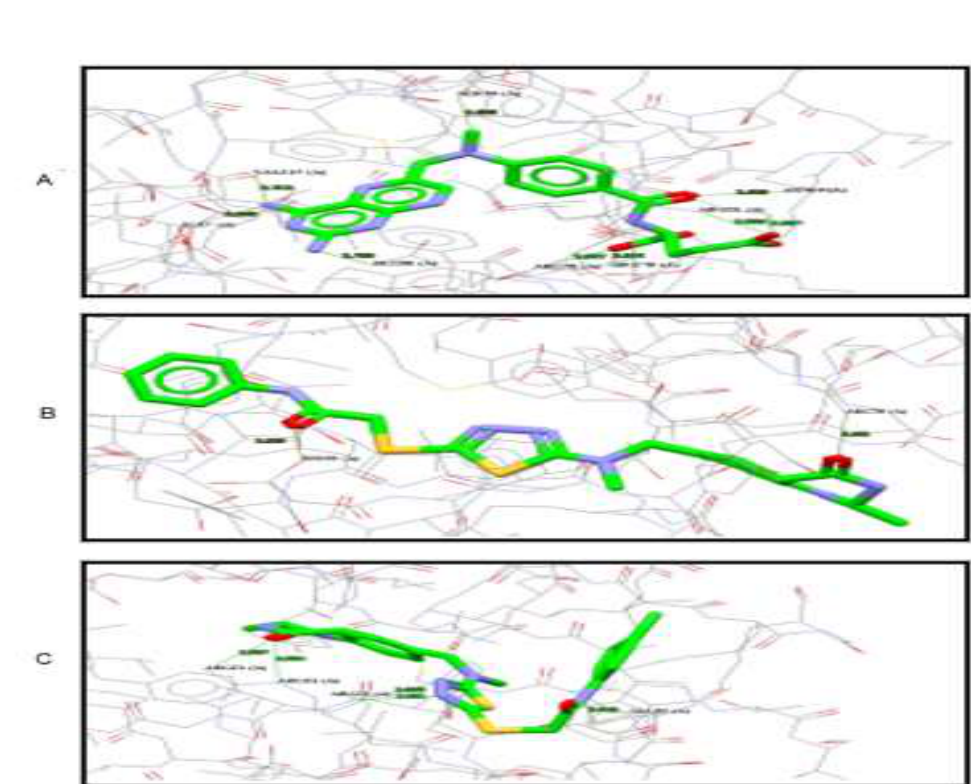
Figure 6 . Comparison of binding mode of methotrexate ( A ), compound S1 ( B ), and compound S2 ( C ) into the binding site of DHFR (PDB: 3EIG). The key amino acid residues are represented by black sticks. Hydrogen bonds are shown as green